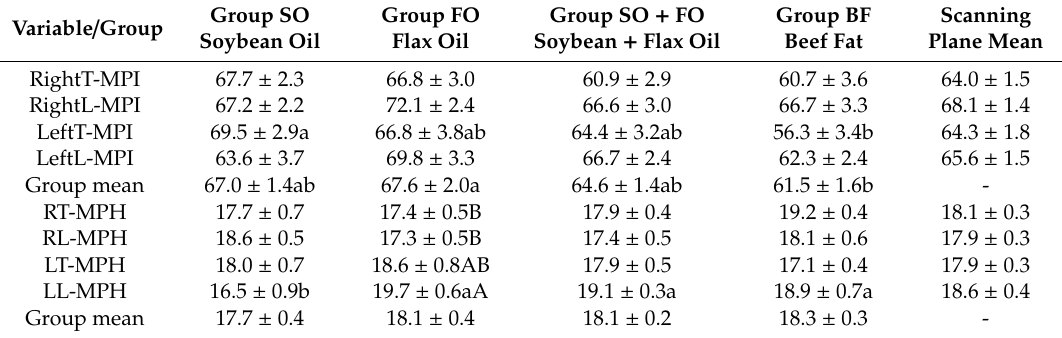
Table 2. Echotextural characteristics of pectoralis major muscles in four fat-supplementation groups of Ross 308 broiler chickens (each n = 10). T: transverse plane; L: longitudinal plane; MPI: mean numerical pixel values (pixel intensity); and MPH: mean pixel heterogeneity (standard deviation of mean numerical pixel values). Means denoted by di ff erent letters are significantly di ff erent ( p < 0.05); ab—within rows and AB—within